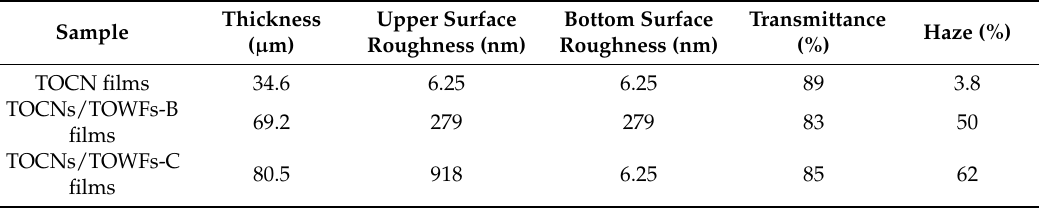
Figure 4. ( a ) FE-SEM image of TOCNs/TOWFs-B films, ( b ) FE-SEM image of TOCNs/TOWFs-C films, ( c ) 3D AFM image of TOCNs/TOWFs-B films surface, ( d ) 3D AFM image of the rough surface of TOCNs/TOWFs-C films, ( e ) cross-sectional structure of TOCNs/TOWFs-B films, and ( f ) cross-sectional structure of TOCNs/TOWFs-C films. Table 1. Thickness, surface roughness, and optical properties of TOCN films, TOCNs/TOWFs-B films, and TOCNs/TOWFs-C